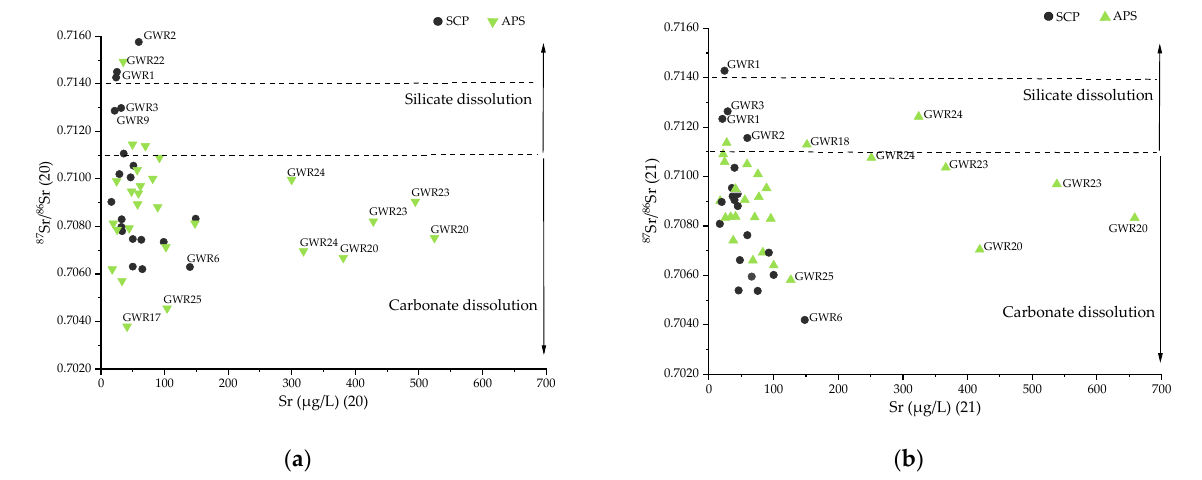
Figure 8. The 87 Sr/ 86 Sr and Sr concentration (µg/L) from the groundwater samples in the year 2020 ( a ), and 2021 ( b ).